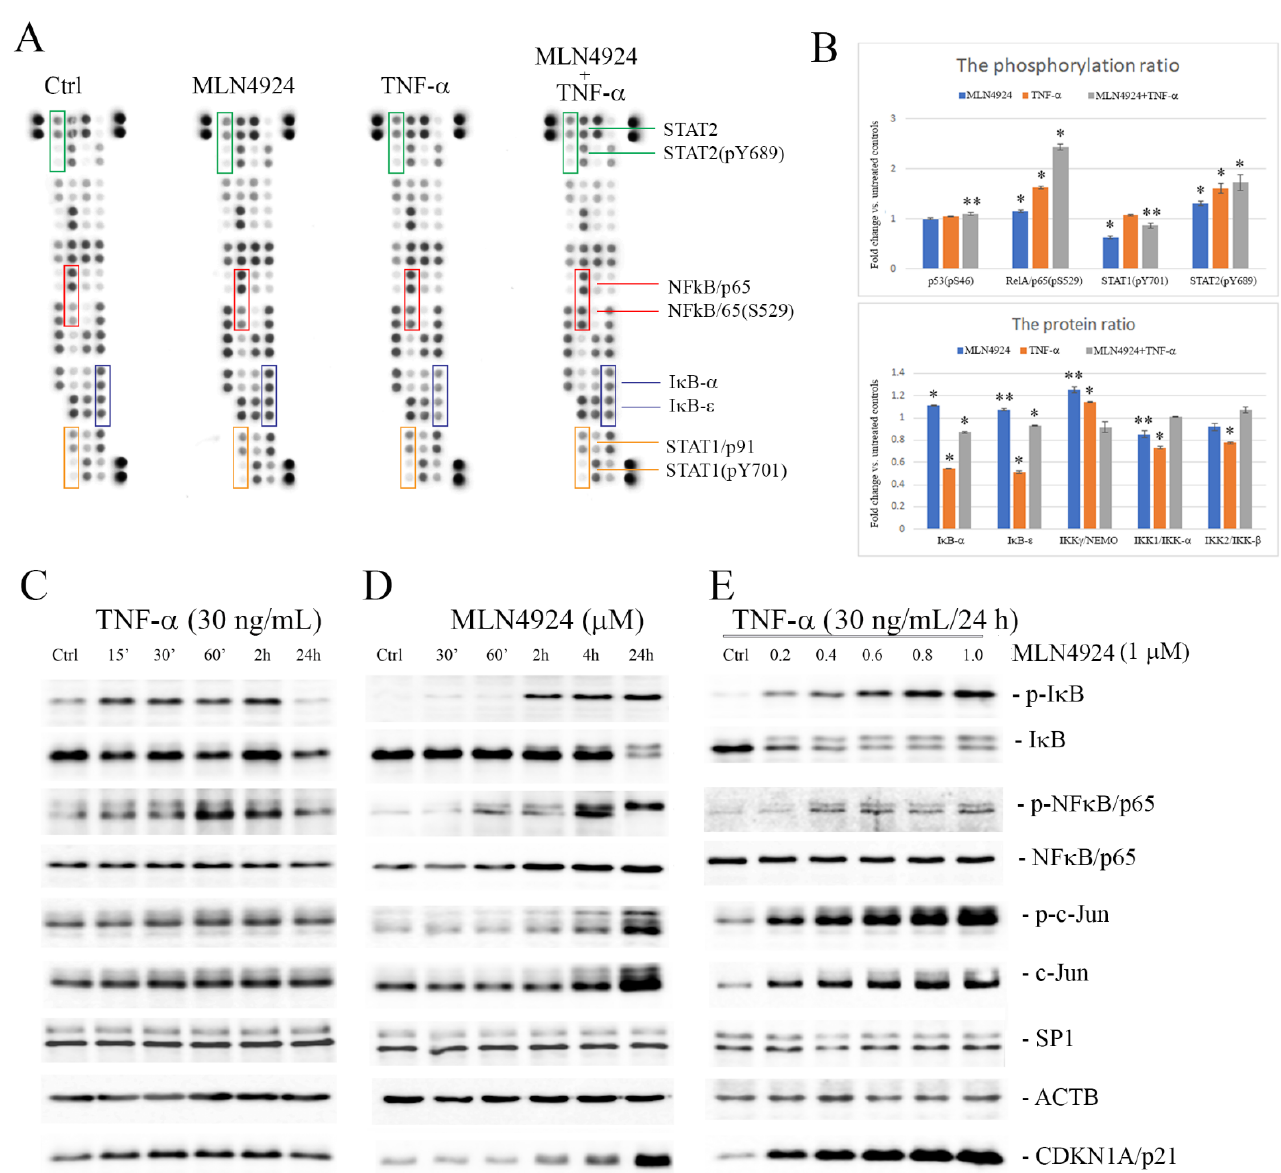
Figure 2. Effect of tumor necrosis factor-alpha (TNF- α ) and MLN4924 on the signaling pathways mediating matrix metalloproteinase 9 (MMP9) gene expression in esophageal squamous cell carcinoma (ESCC) cells. ( A ) Proteome profiling of the nuclear factor kappa B (NF κ B) pathway by antibody array analyses in the KYSE150 cells treated with MLN4924 and TNF- α . Protein lysates from the untreated controls and cells treated with MLN4924 or TNF- α alone or in combination were analyzed using a human NF κ B array (R&D). ( B ) Bar graphs showing the phosphorylation ratio (upper) and the protein level ratio (bottom) calculated after the semi-quantitative analysis of selected proteins. Results are presented as means ± SEM from duplicates. * p < 0.001, ** p < 0.05 vs. controls. The complete array is shown in Figure S3. ( C ) Western blot analysis showing time-dependent activation of inhibitor of nuclear factor kappa B-alpha (I κ B- α ), NF κ B/p65 and c-Jun in the KYSE150 cells treated with TNF- α (30 ng/mL). ( D ) MLN4924-dependent changes in the activation of I κ B- α , NF κ B/p65 and c-Jun as well as increasing levels of cyclin dependent kinase inhibitor 1A (CDKN1a/p21) protein in the KYSE150 cells within 24 h. ( E ) A dose-dependent effect of MLN4924 on activation of NF κ B/p65 and c-Jun signaling path- ways in the KYSE150 cells treated with TNF- α (30 g/mL) for 24 h. The effect of the KYSE70 cells treatment with different concentrations (0.25, 0.5, 1.0, 2.5 and 5.0 µM) of MLN4924 for 24 and 48 h is shown in Figure S2. Thereafter, to clarify the mechanism by which NF κ B/p65 may be involved in MLN4924-dependent inhibition of TNF- α -induced MMP9 gene expression in ESCC cells, the levels of phospho-NF κ B/p65 (Ser536) and phospho-I к B- α (Ser32) were analyzed in